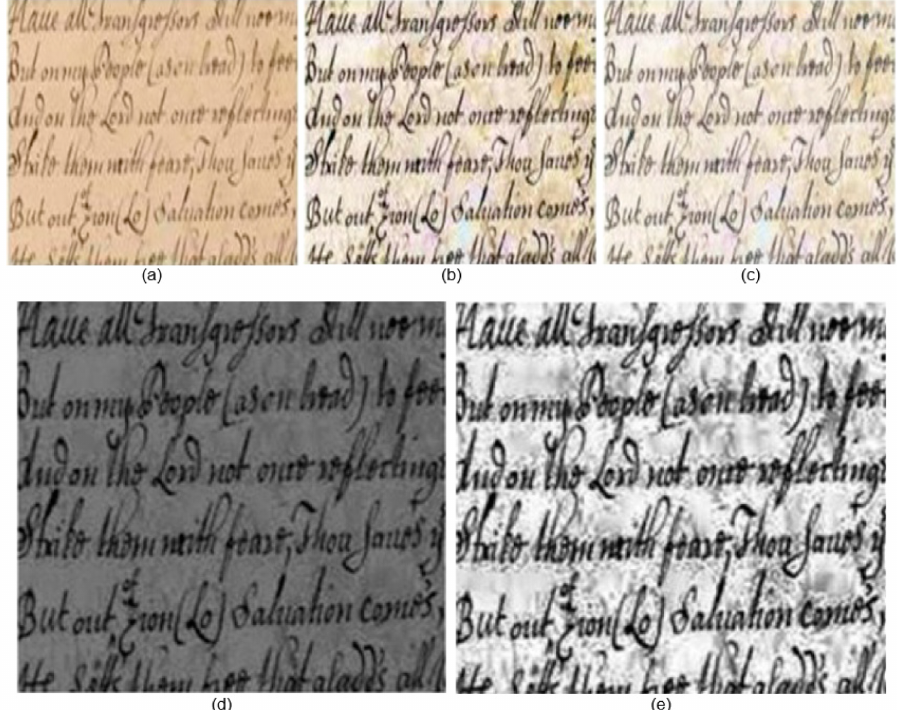
Figure 8. Qualitative results using Blurry document images dataset [5]: ( a ) input image, ( b ) S. Kang [2], ( c ) S. K. Jemni [3], ( d ) proposed LWT and SWT bi-cubic interpolation result, ( e ) proposed final